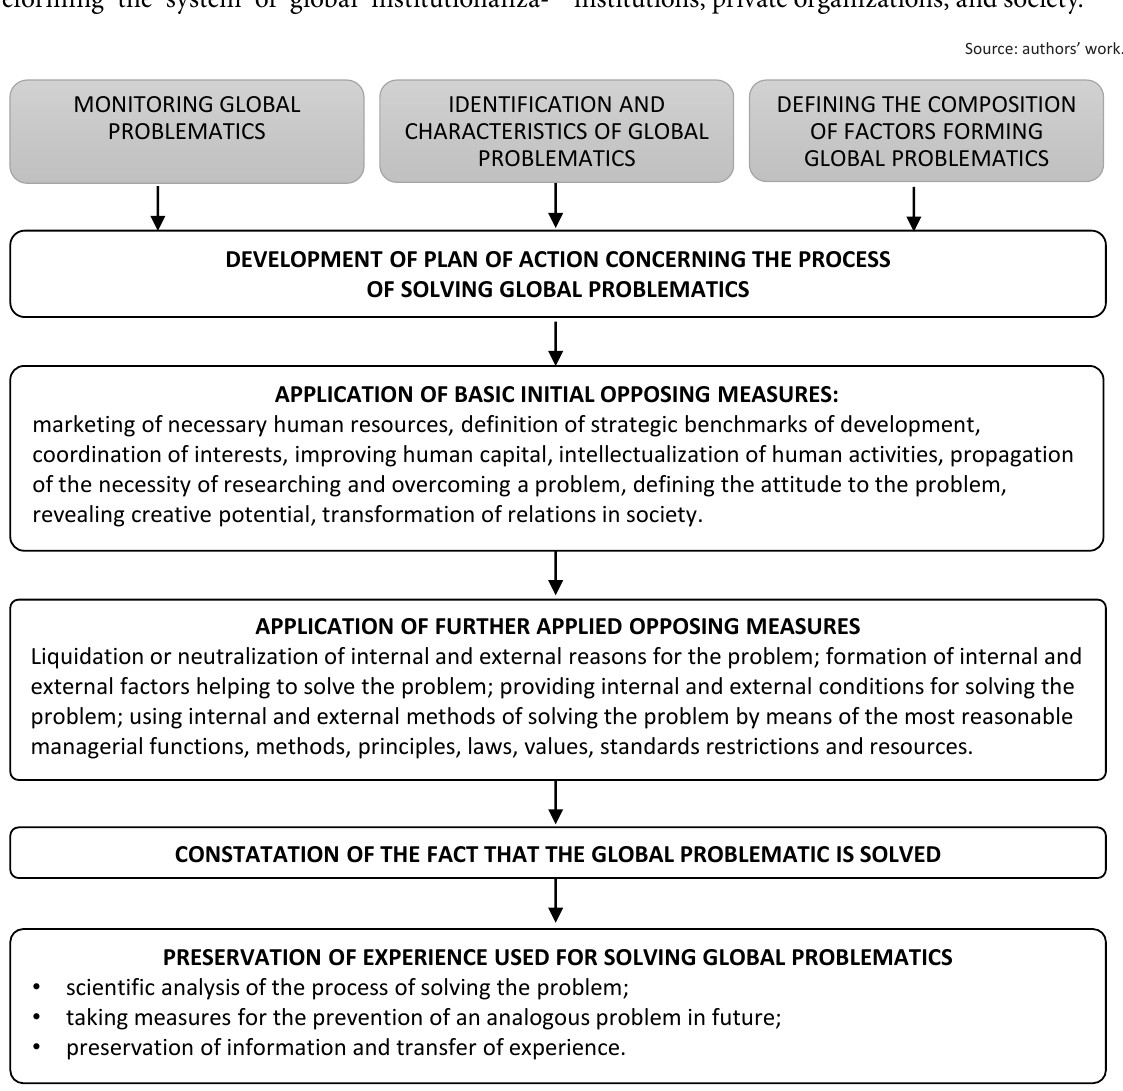
Figure 2. Simplified scheme of the mechanism for solving the global